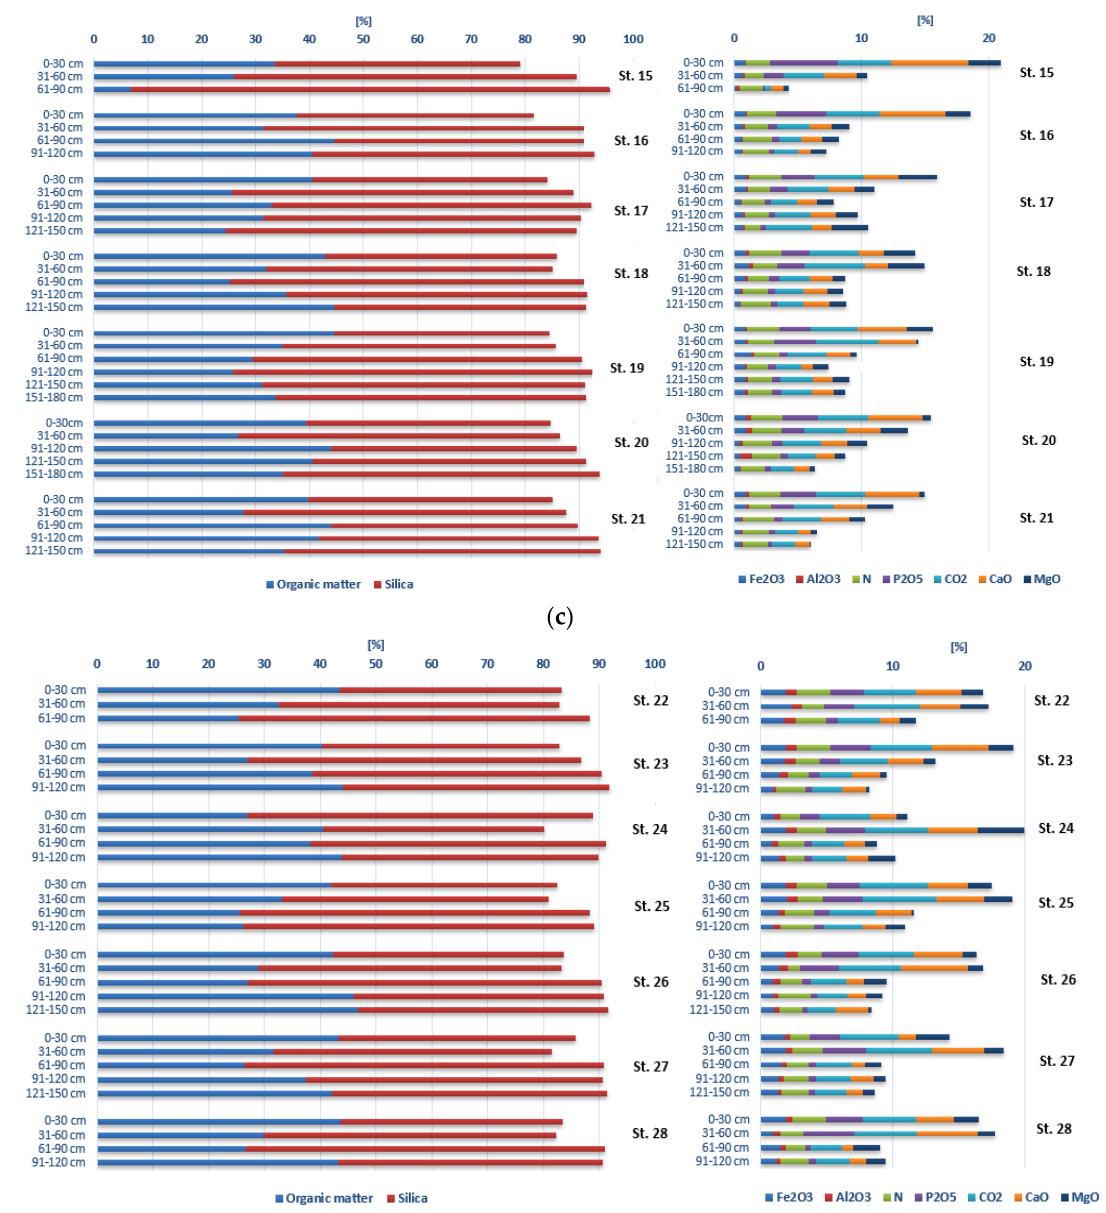
Figure 8. ( a ) The mean chemical composition of bottom sediment of Karczemne Lake—Stations 1–7; ( b ) the mean chemical composition of bottom sediment of Karczemne Lake—Stations 8–14; ( c ) the mean chemical composition of bottom sediment of Karczemne Lake—Stations 15–21 and ( d ) the mean chemical composition of bottom sediment of Karczemne Lake—Stations 22–28.